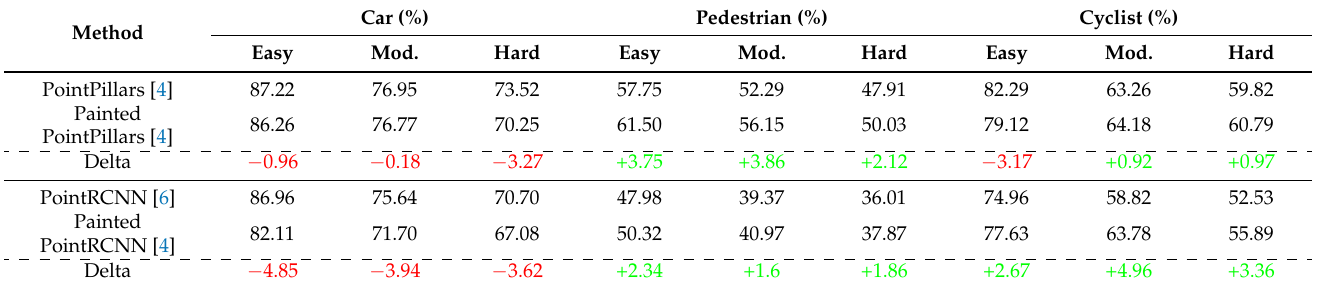
Table 1. Deterioration of car detection performance by sequentially appending image semantic segmentation results to point cloud. Test results of Painted PointPillars are obtained on the validation set using the official implementation, while the test results of Painted PointRCNN are from the KITTI